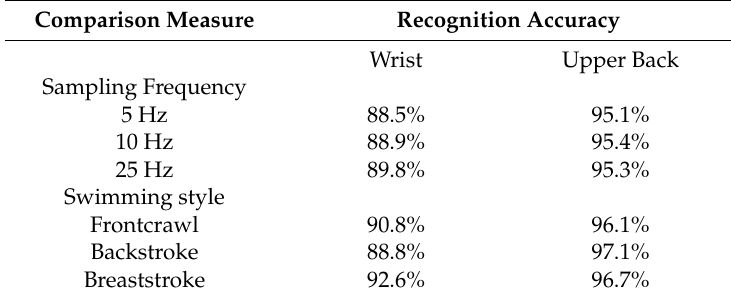
Table 3. Results of automatic stroke style identification, comparing different sensor locations and sampling frequencies. The back worn device produced more accurate results for all styles and sampling frequencies. Note that the results provided for the three swimming styles relate to data calculated at 5 Hz. Adapted from Siirtola, Laurinen, Roning and Kinnunen